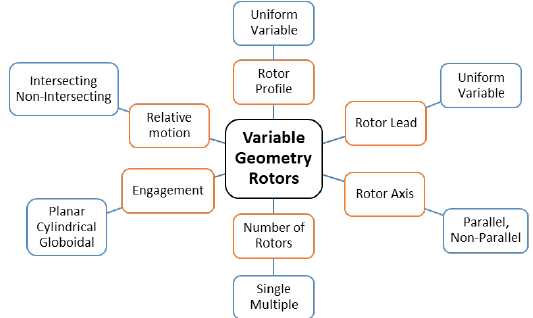
Figure 2. A representation of possibilities for rotary screw machine geometries [1].